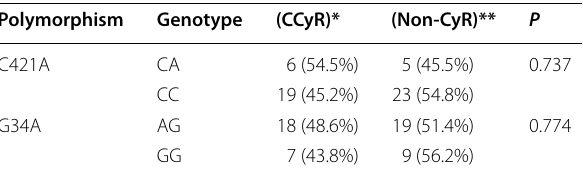
Table 6 The comparison of cytogenetic response between different genotype